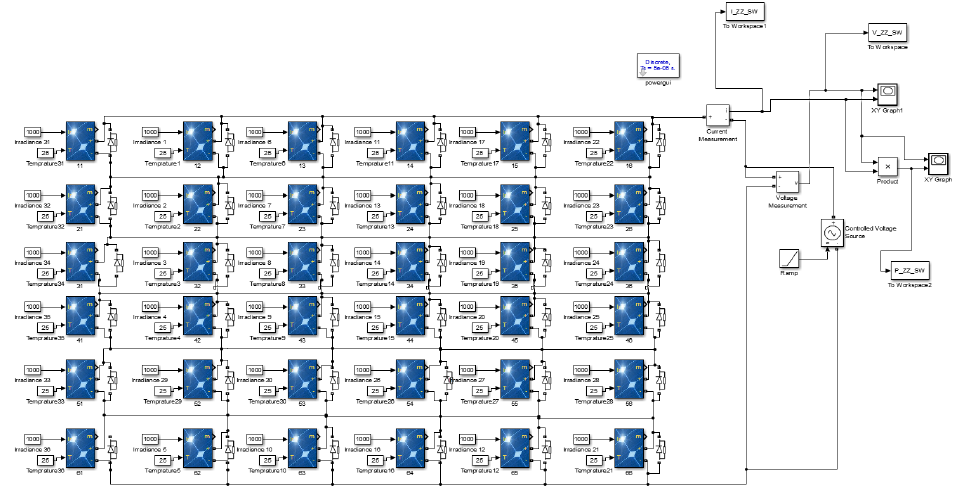
Figure 3. Panel positions in PV array ( a ) conventional methods, ( b ) NSD method.